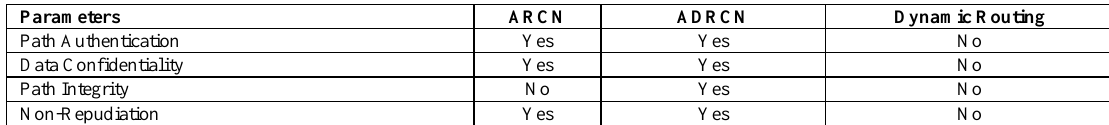
Table 3. Comparison of security